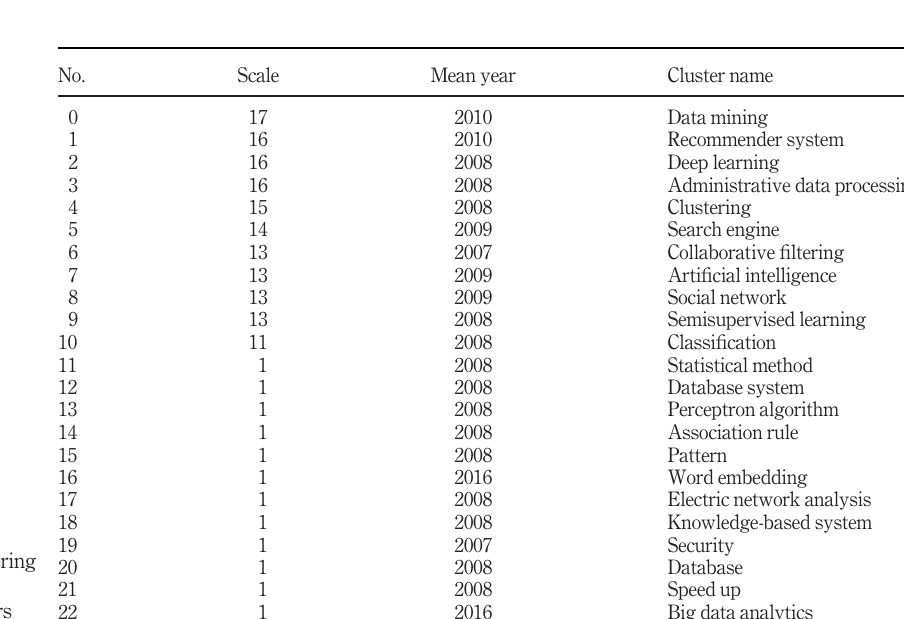
Figure 2. Data mining authoritative conference annual papers based on LLR clustering view